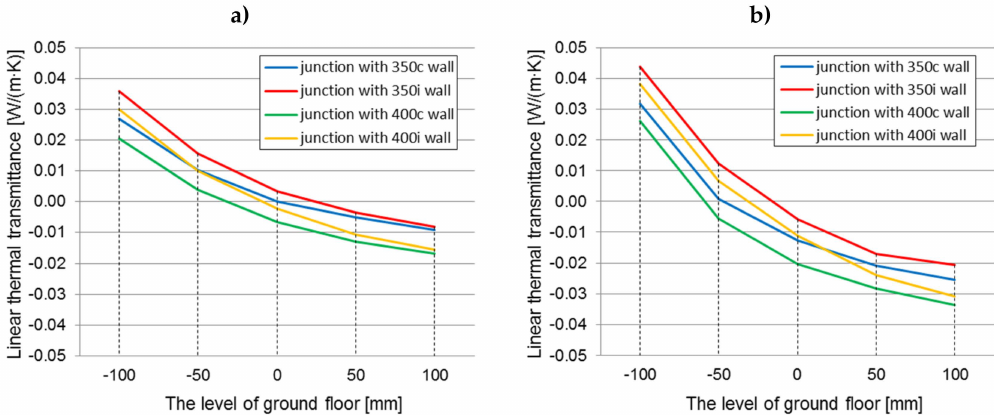
Figure 10. The linear thermal transmittance coe ffi cient (calculated using the internal dimensions) of the ground junction in all construction variants of walls filled with hemp–lime composite ( λ = 0.080 W / (m · K)), dependent on the floor level on the ground: ( a ) floor on joists; ( b ) self-supporting